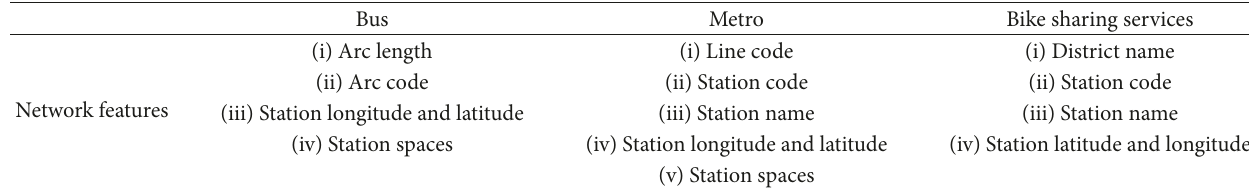
Table 2: Effective fields of public transport network features